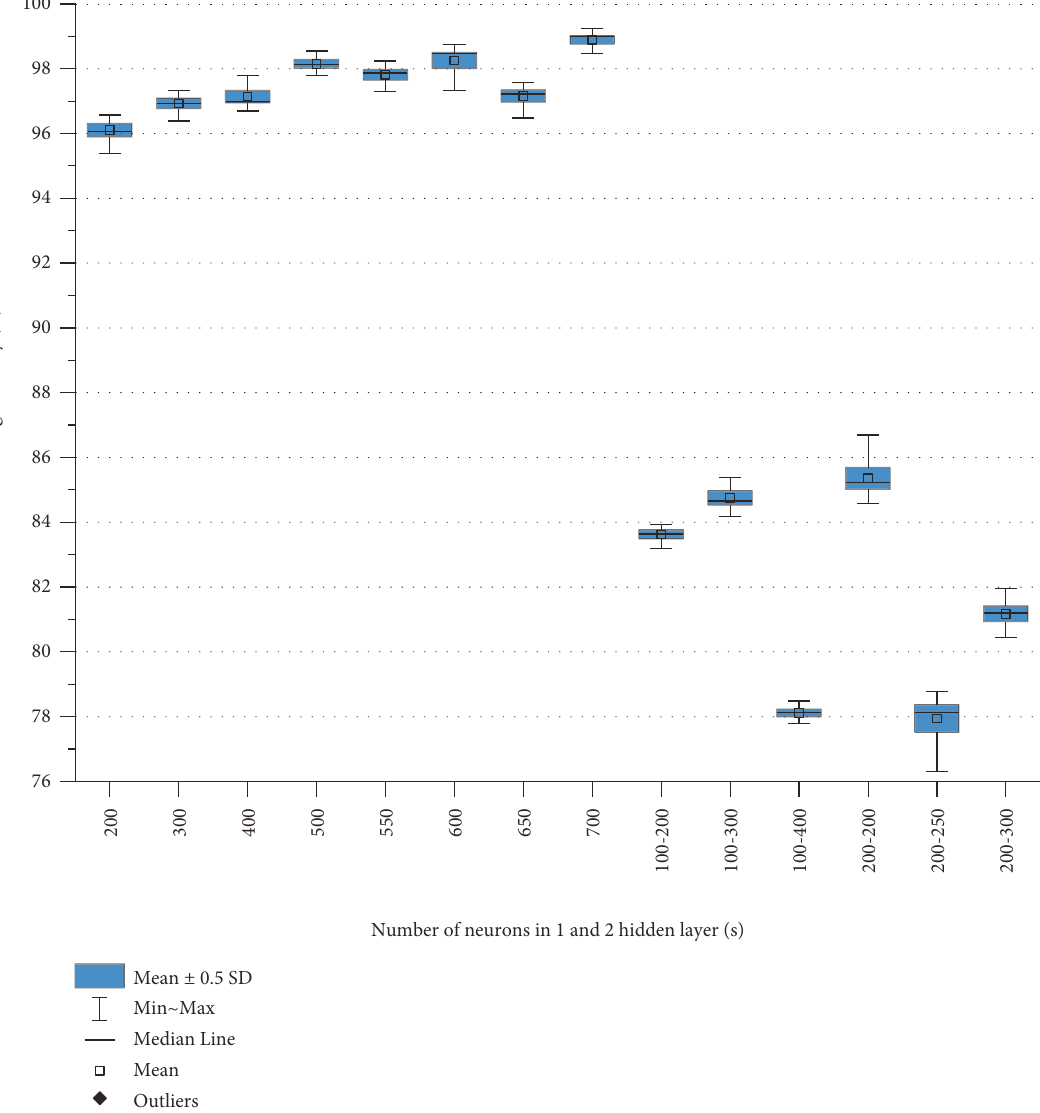
Figure 7: Predicted induction heating surface accuracy